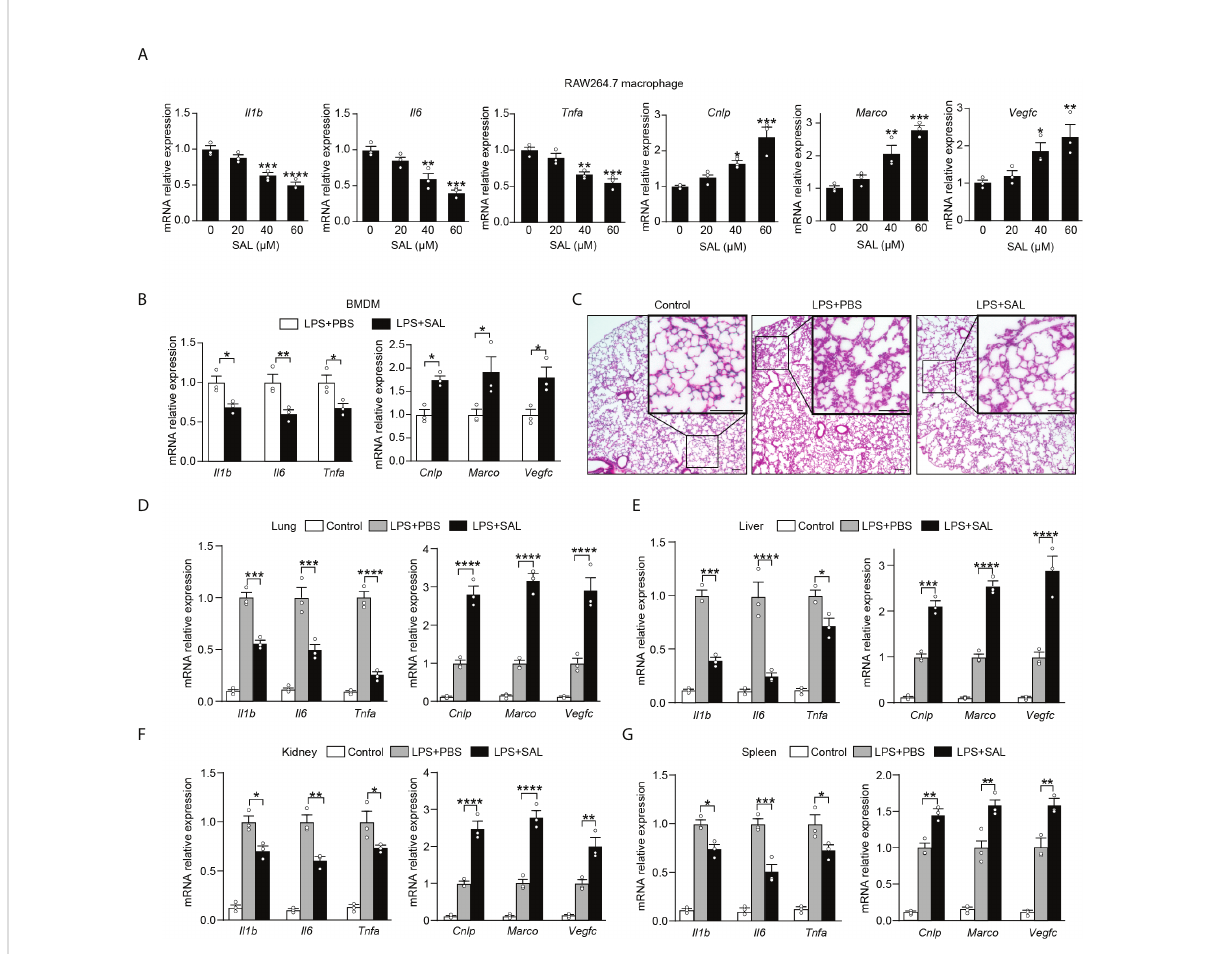
FIGURE 4 Induction of endogenous EPO by SAL improved endotoxin-tolerant re-programming (A) : In vitro cultured RAW264.7 macrophages were pretreated by LPS (100 ng/ml) together with different doses of SAL (0, 20, 40 and 60 m M) for 24 h. Then, cells were washed with PBS twice followed by a secondary LPS stimulation (10 ng/ml) for 6 h, and mRNA levels were measured by qRT-PCR (n = 3). (B) : In vitro cultured BMDMs from WT C57BL/6 mice were pretreated by LPS (100 ng/ml), together with SAL (60 m M) or PBS for 24 h. Then, cells were washed with PBS twice followed by a secondary LPS stimulation (10 ng/ml) for 6 h, and gene expression was measured by qRT-PCR (n = 3). For (C – G) : WT C57BL/6 mice were intraperitoneally injected with LPS (1 mg/kg) together with SAL (40 mg/kg) or PBS for 24 h, and then these mice were intraperitoneally given with a secondary LPS injection (10 mg/kg) for 6 h. Control mice were injected with PBS only. (C) : Lung specimens stained with H&E (bar = 100 m m, n = 3). (D – G) : qRT-PCR assay of gene expression in mice ’ s lung (D) , liver (E) , kidney (F) , and spleen (G) (n = 3). Results were expressed as means ± SEM. *P < 0.05, **P < 0.01, ***P < 0.001, and ****P < 0.0001. Statistics: one-way ANOVA (A) or two-way ANOVA (D – G) with Tukey ’ s post-hoc test for multiple